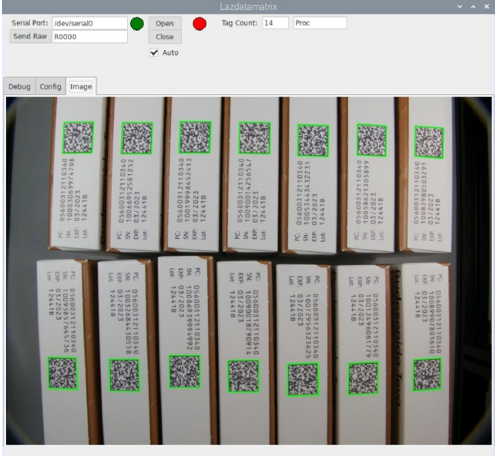
Figure 7. User interface showing the Data Matrix detection illustrated by the green